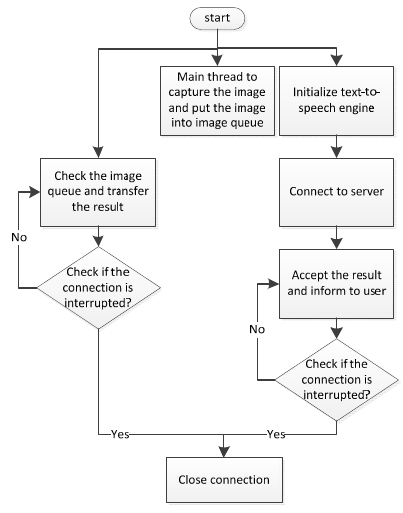
Figure 7. RTP transmission.